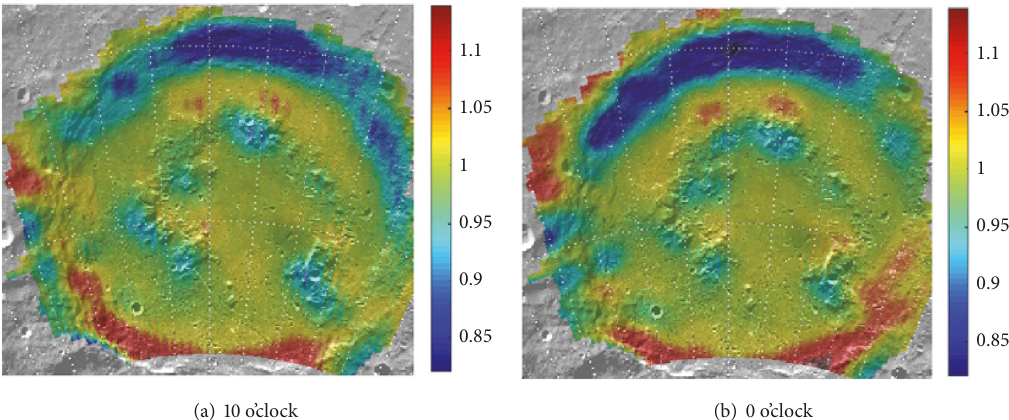
Figure 9: 37-GHz n T map overlays on WAC image with 60% B